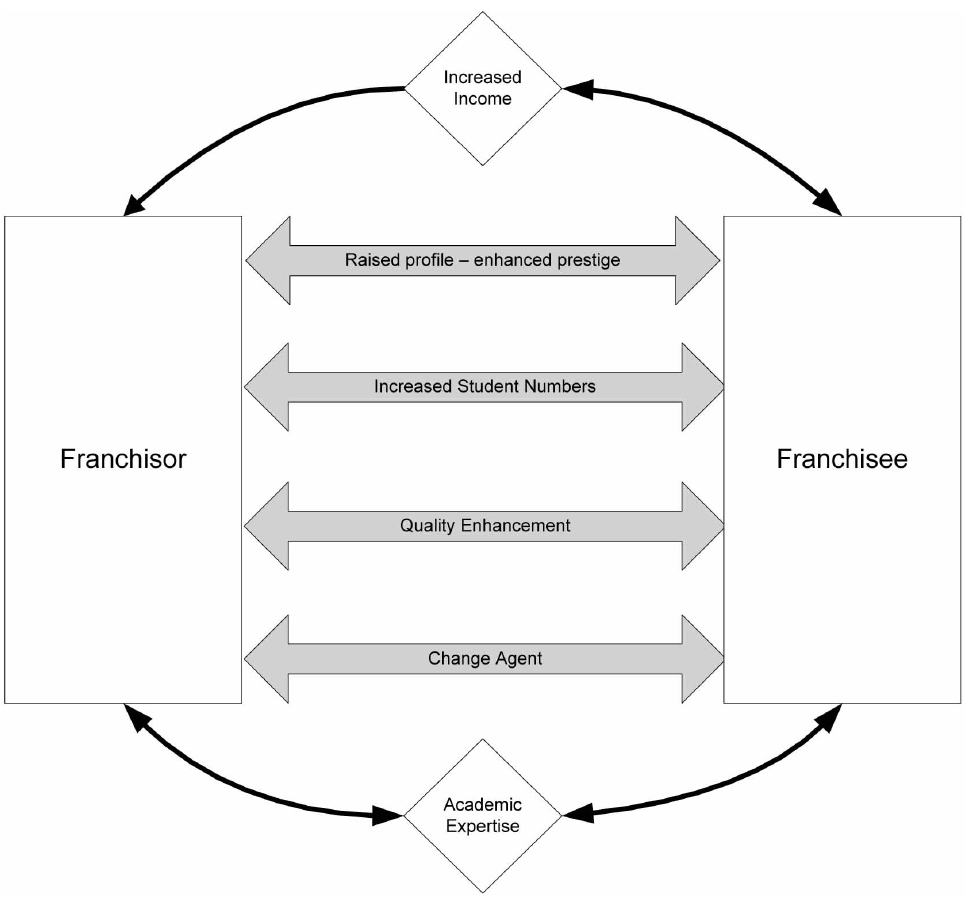
Figure 2: A new model of academic franchising and the flow of